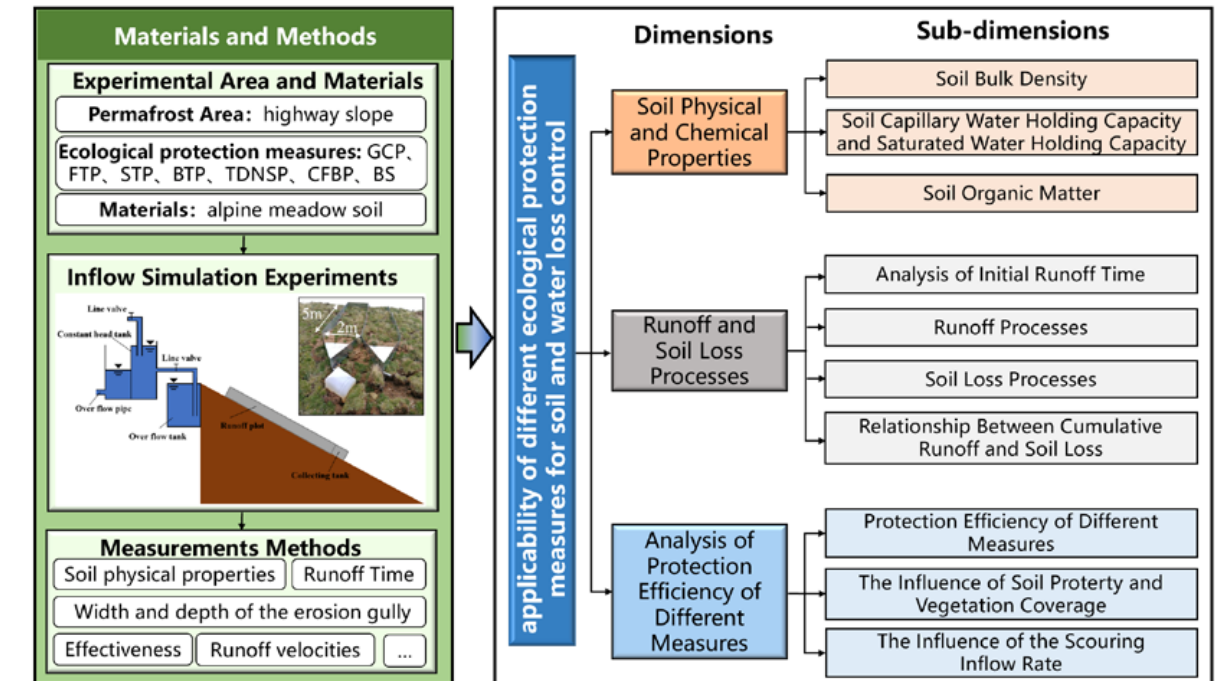
Figure 1. Research framework adopted in this paper.